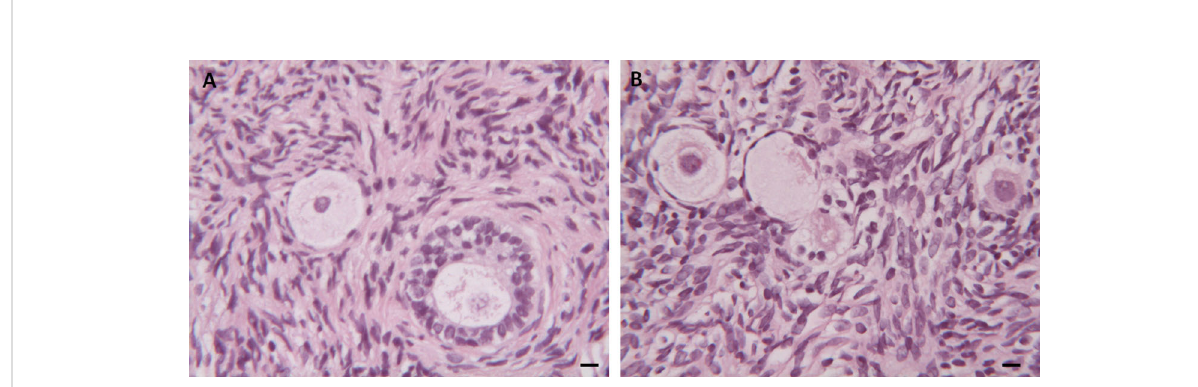
FIGURE 2 Histological Analysis. (A) Morphological appearance of follicles and stroma in fresh ovarian tissue. (B) Mild interstitial edema, widespread vacuolization and chromatin in thawed ovarian samples. Scale Bar 25 µm.